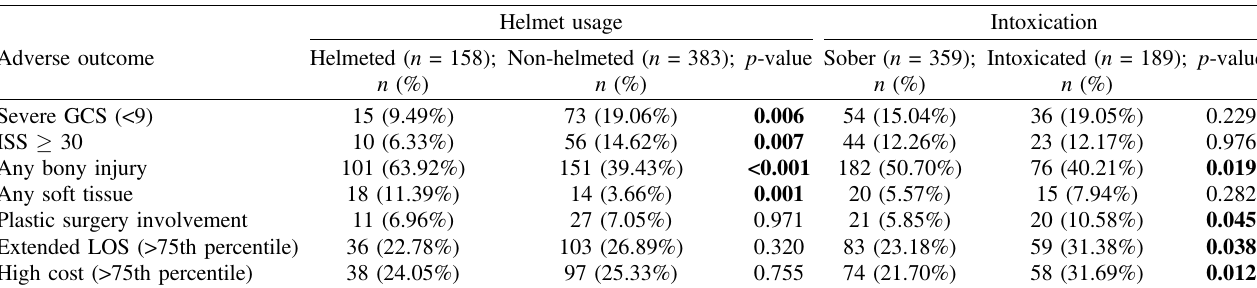
Table 3. Impact of helmet usage and intoxication on selected adverse outcomes.